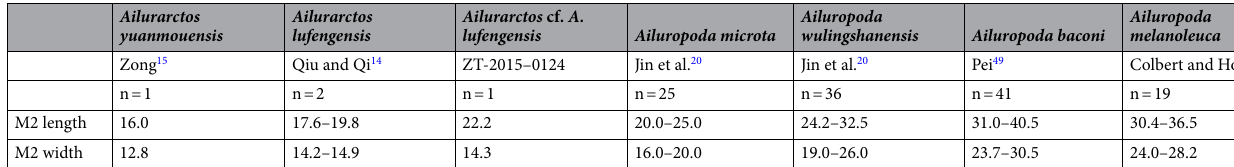
Table 1. Comparison of dental measurements (in mm).